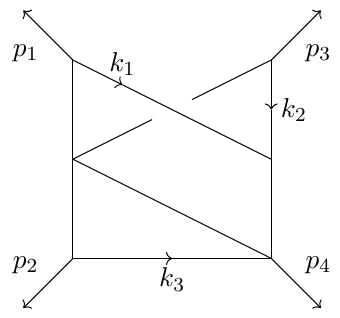
Figure 5 . To reveal the (cid:15) (cid:0) 6 pole we take the following consecutive limits: 1) k 1 collinear to p 1 , 2) k 2 collinear to p 1 , 3) k 2 collinear to p 3 , 4) k 1 collinear to p 3 , 5) k 3 soft, 6) k 3 collinear to p 2